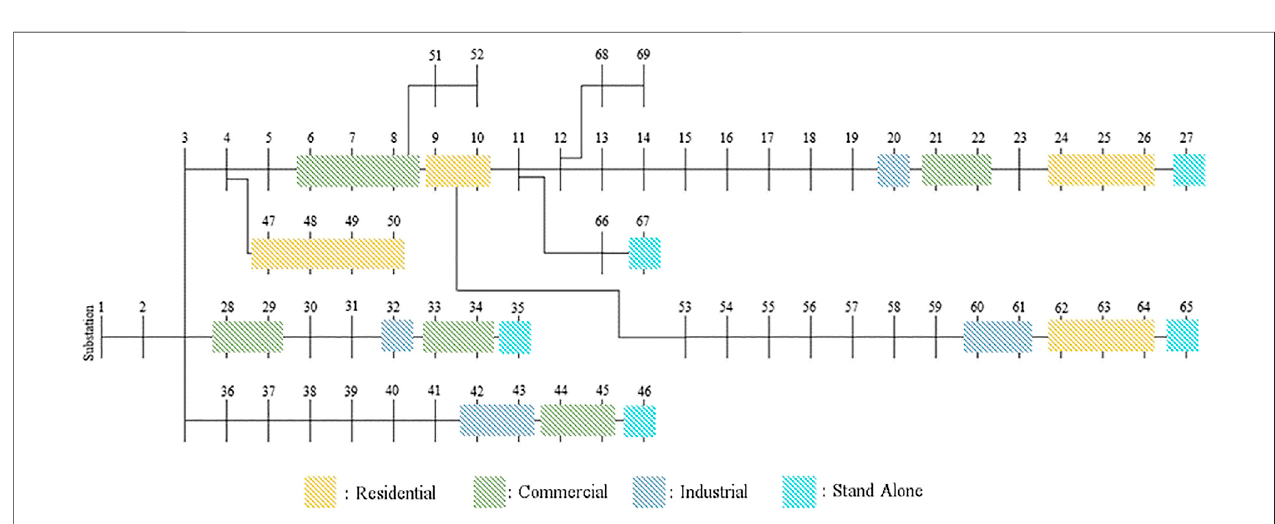
FIGURE 7 | Con fi guration of 69-bus distribution system with